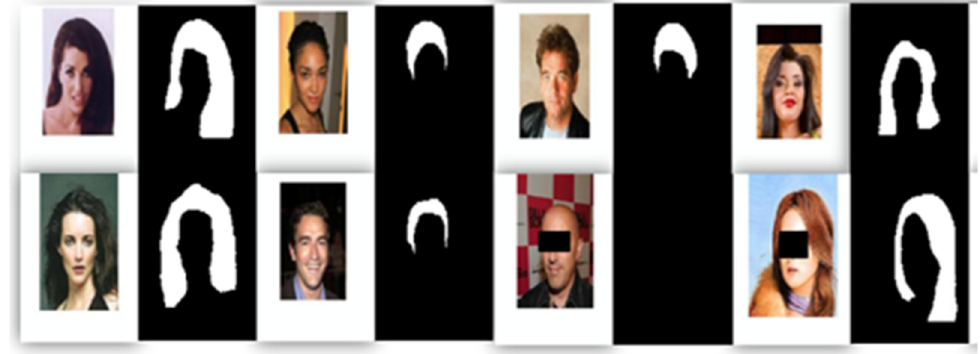
Figure 9. Good results of the proposed method.